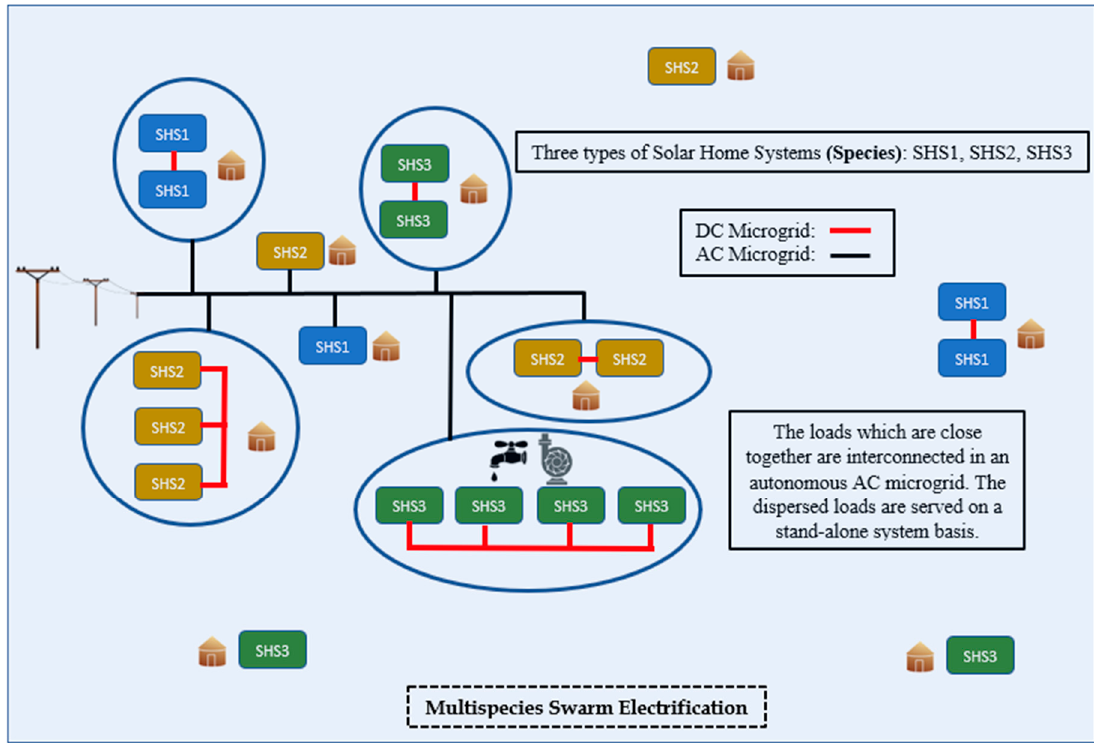
Figure 1. Multispecies Swarm Electrification Ecosystem.